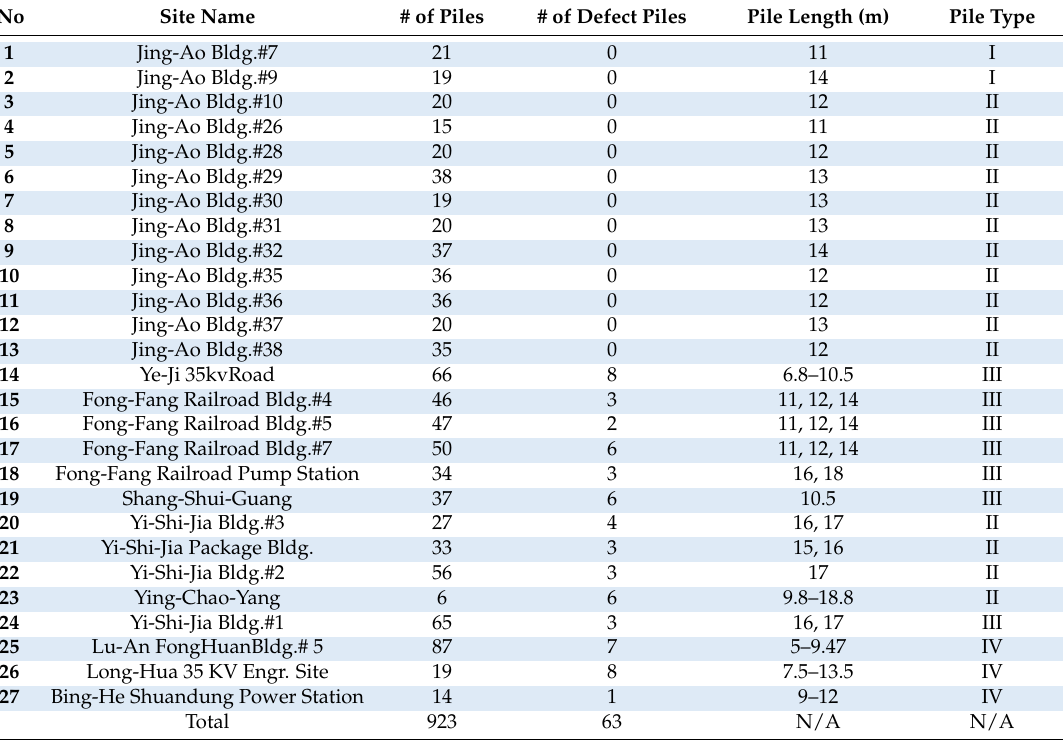
Table 1. Pile and construction site